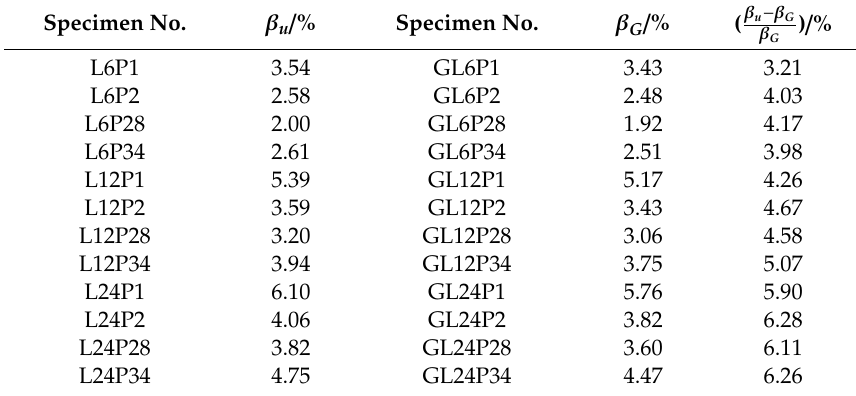
Table 5. Comparison of the relaxation rate of the unglue specimen (subscripted “u”) and the relaxation rate of the glue specimen (subscripted “G”).